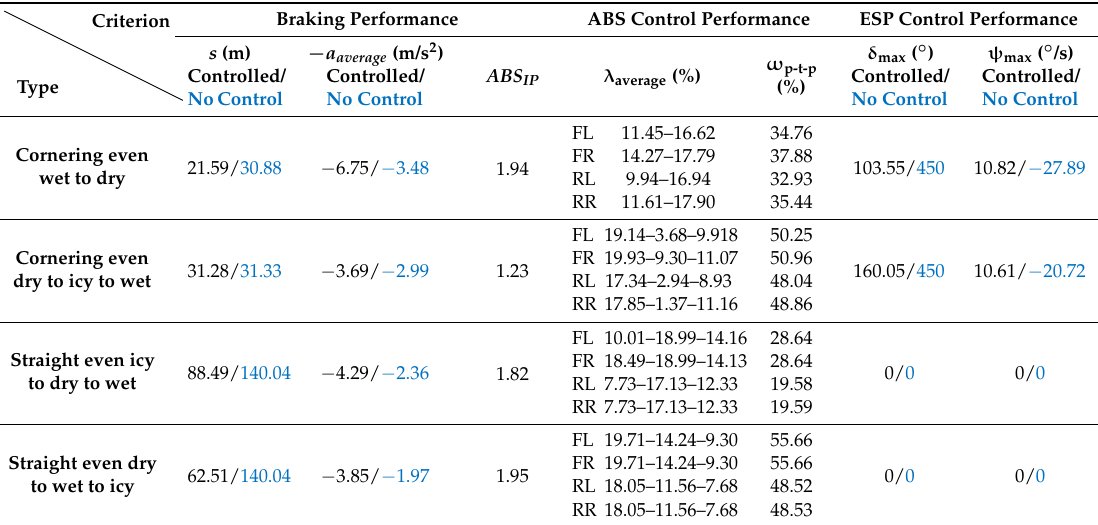
Table 7. Controller robustness